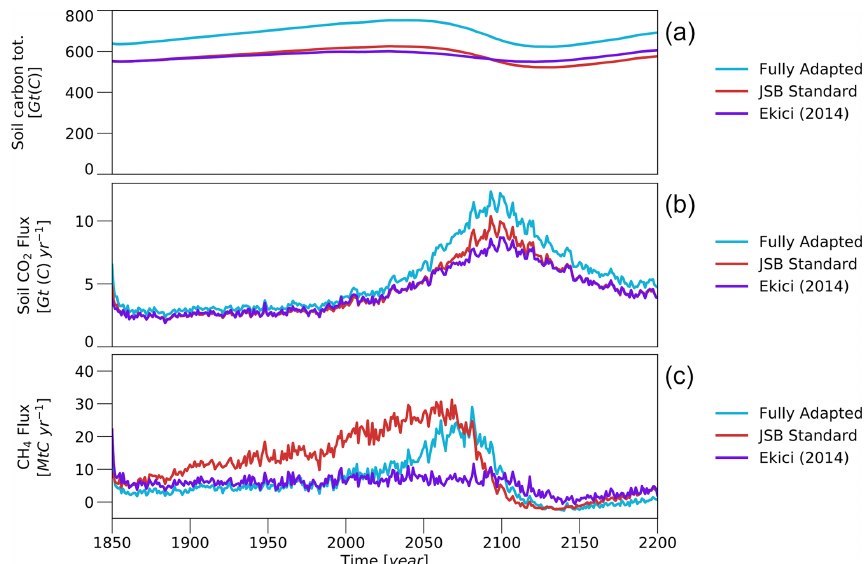
Figure A2. Soil physics. Same as Fig. A1 but showing differences with respect to key assumptions in the JSBACH (JSB) soil-physics module. Light-blue lines show simulations with the fully adapted model as described in Sect. 2. Red lines show simulations that are closer to the standard JSBACH model in that they assume vertically homogeneous organic matter properties, while infiltration at sub-zero temperatures is prevented, and the supercooled water can move vertically through the soil and is available for microbial decomposition. Purple lines show simulations that account for the impact of organic matter on the soil properties only at the top of the soil column, while the lower layers have the properties of mineral soil. The latter provides a model version that is close to the setup used by Ekici et al. (2014,